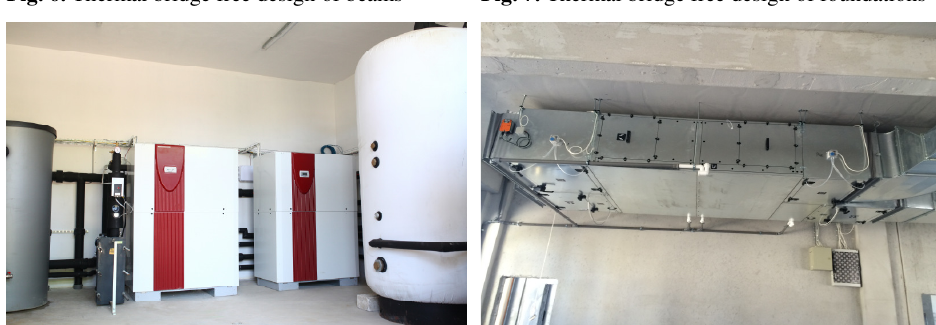
Fig. 8. Mechanical room heat pumps and boiler Fig. 9. Mechanical ventilation